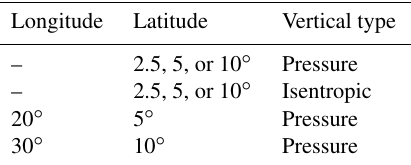
Figure 5. WV offsets relative to Aura MLS for satellite data sets used in SWOOSH. WV offsets are defined as the mean of MLS minus the given data set. Offsets are computed on the MLS vertical grid in 10 ◦ latitude bands. Table 4. Available SWOOSH grids.